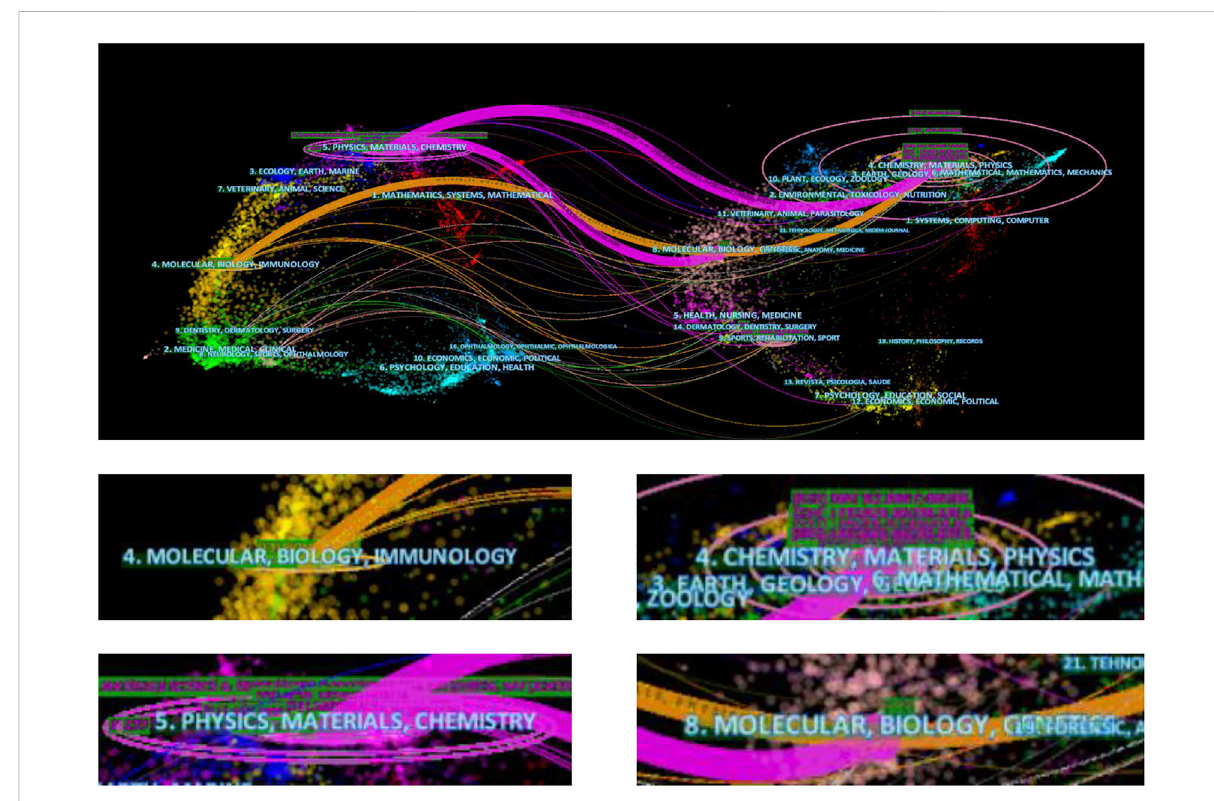
FIGURE 9 Related fi eldsofmetal materialsandbonerepair.Theleftsiderepresentsthe fi eldsofarticlesincludedinthestudy,andtherightsiderepresents the fi elds of the references of the